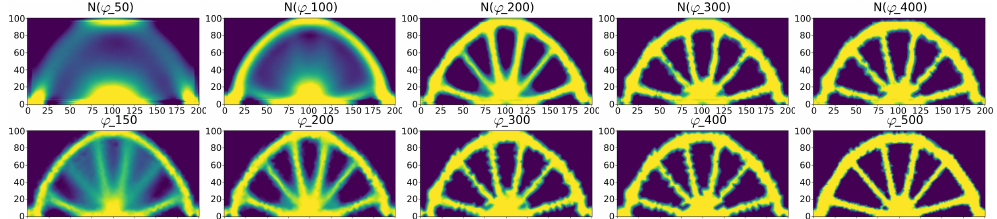
n + 25 ( bottom row ).